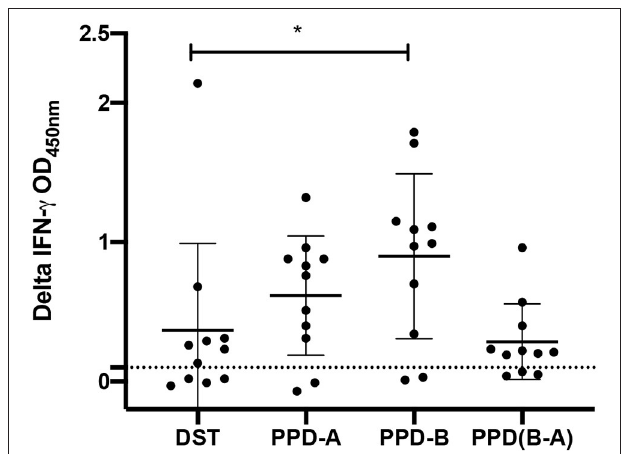
FIGURE 1 | Capacity of DST antigens to induce an in vitro IFN- γ response in whole blood collected from naturally infected buffaloes ( n = 11). The background-corrected optical density (OD) values for all antigens tested are shown. The horizontal line indicates the mean ( ± SD), and the statistical difference between the responses was determined by using the paired t -test (* P < 0.05). The means of background-subtracted OD values for DST, PPD-A, PPD-B, and PPD(B-A) were found to be 0.37, 0.62, 0.90, and 0.29, respectively. The standard deviations for DST, PPD-A, PPD-B, and PPD(B-A) were 0.62, 0.43, 0.60, and 0.27,